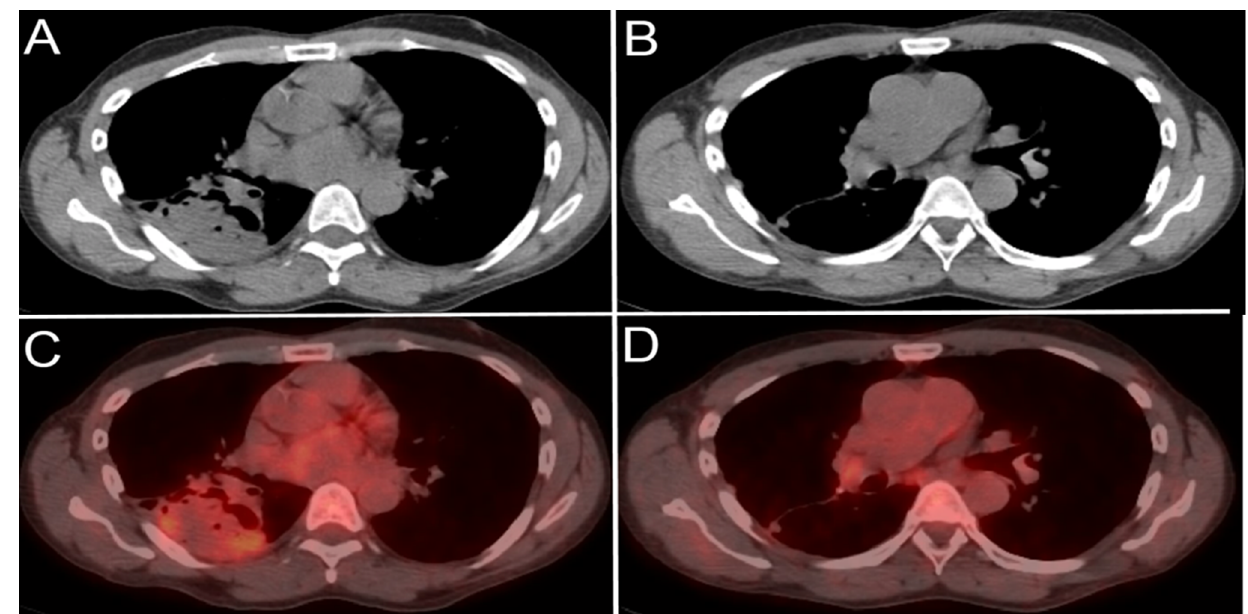
Figure 14. A 65-year-old male patient with right lower lobe lung cancer. The pulmonary mass seen in ( A ) shows avid FDG uptake (SUV = 4.6) in ( C ). Right hilar and subcarinal lymph nodes show mild FDG uptake (SUV = 2.6), which was found later to be inflammatory due to chemotherapy, resolving on ( B , D ). This is an example of false positive uptake in nonmalignant tissue.